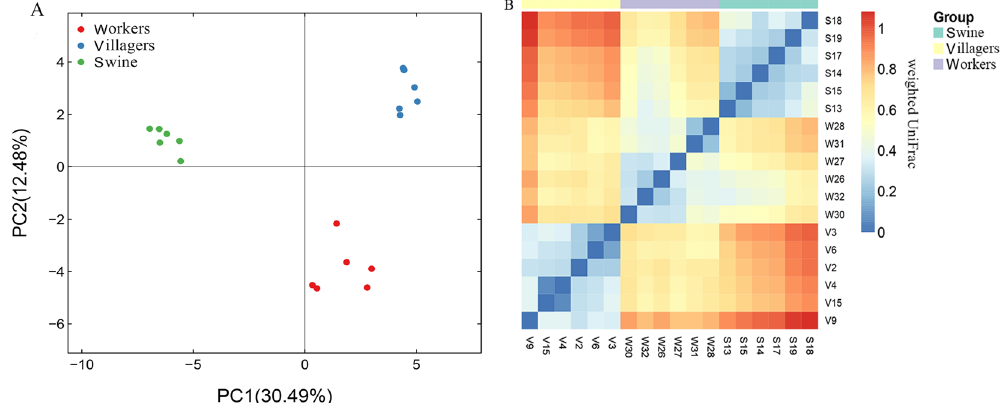
Figure 2. Principal components analysis (PCA) and β diversity. Panel (A): PCA plot describing the dissimilarity between three different groups. Colored markers are used to differentiate samples. Panel (B): Heatmap of diversity distance calculated by weighted Unifrac. The distance index ranges from absent (blue) to abundant (red).